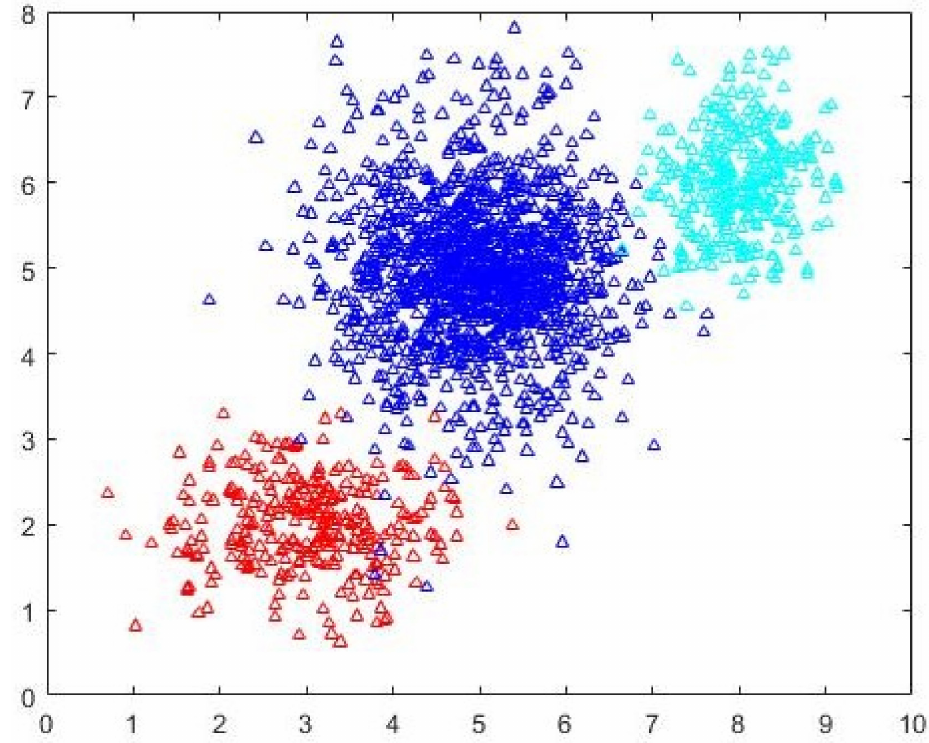
Figure 10. Partition by CDE-FCM, c = 3 with initial cluster prototypes shown in Figure 7. Iris data consists of n = 150 datapoints divided into three types of Iris flowers-Setosa, Virginica, and Versicolor with 50 samples in each class. Each sample has four associated features: sepal length, petal length, sepal width, and petal width. FCM-AO, PSO-V, GAKFCM and EwFCM are run for c = 2 to c = 12. For ADEFC and CDE-FCM the vector representation is of length 48 with d = 4 and c max = 12. The performances of different